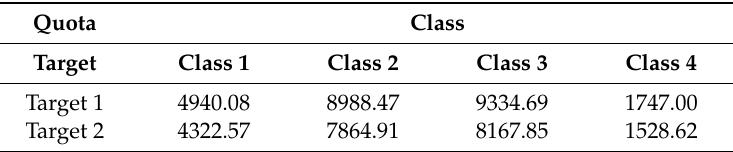
Table 9. Quota allocation results at the first